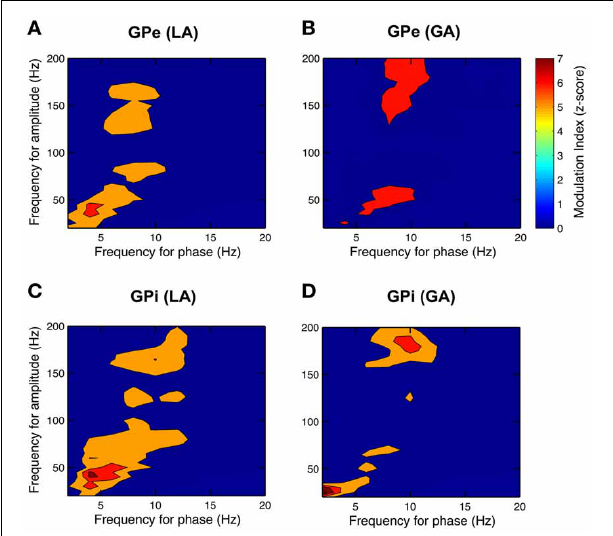
FIGURE 9 | Phase–amplitude coupling in the GP of CD patients differs between LA and GA. All panels depict grand averages across subjects and show values of z -scored modulation indices that reached statistical significance (Bonferroni-corrected z -score > 4). Co-modulograms of both GPe– (A) and GPi–LFPs (C) under LA revealed strong cross-frequency coupling between theta phase and amplitude in the lower gamma band. Under GA, this theta–gamma co-modulation was shifted toward higher frequencies for both phase and amplitude in the GPe (B) and was completely absent in the GPi (D) . A significant cross-frequency interaction between alpha-phase and amplitude in the higher gamma range was observed in both structures and under both anaesthetic